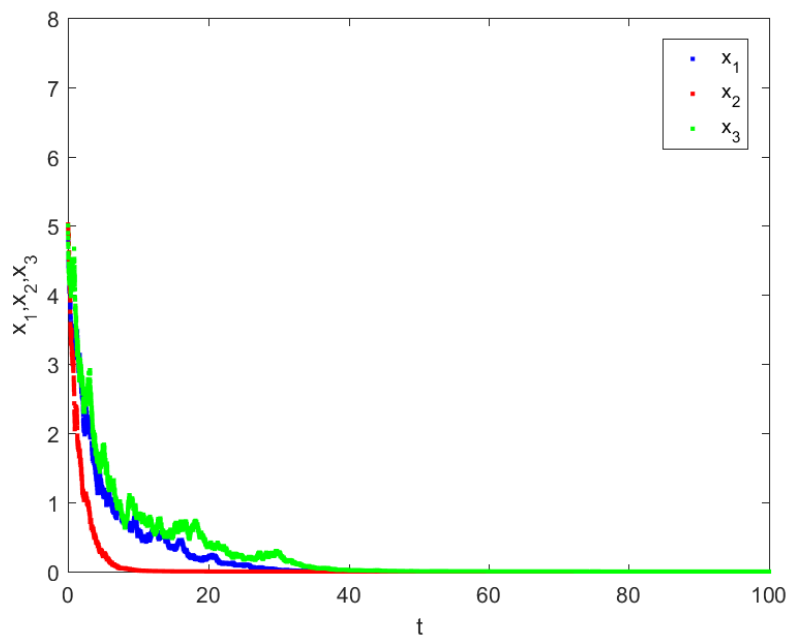
Figure 3. The stochastic trajectories for the trivial solutions of the stochastic Hantavirus infection system (3).